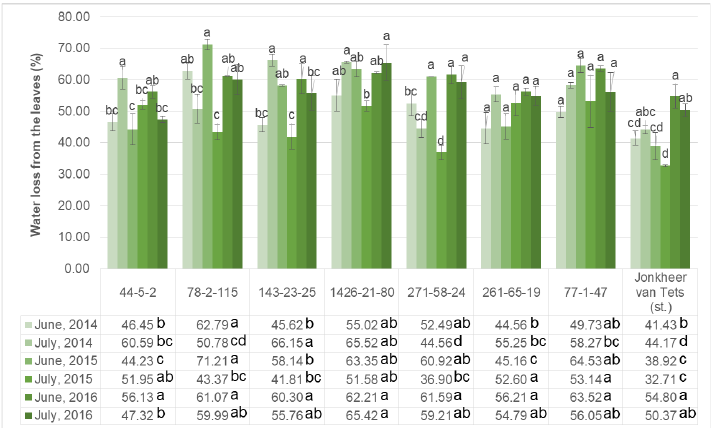
Figure 2. Water loss from the leaves of selected red currant genotypes during growing period. (Letters above the columns are used to compare growing periods separately for each genotype; and letters next to the values in figure table are used to compare genotypes separately for each growing period. Different letters shown represent significant difference among the values according to Tukey’s HSD test).